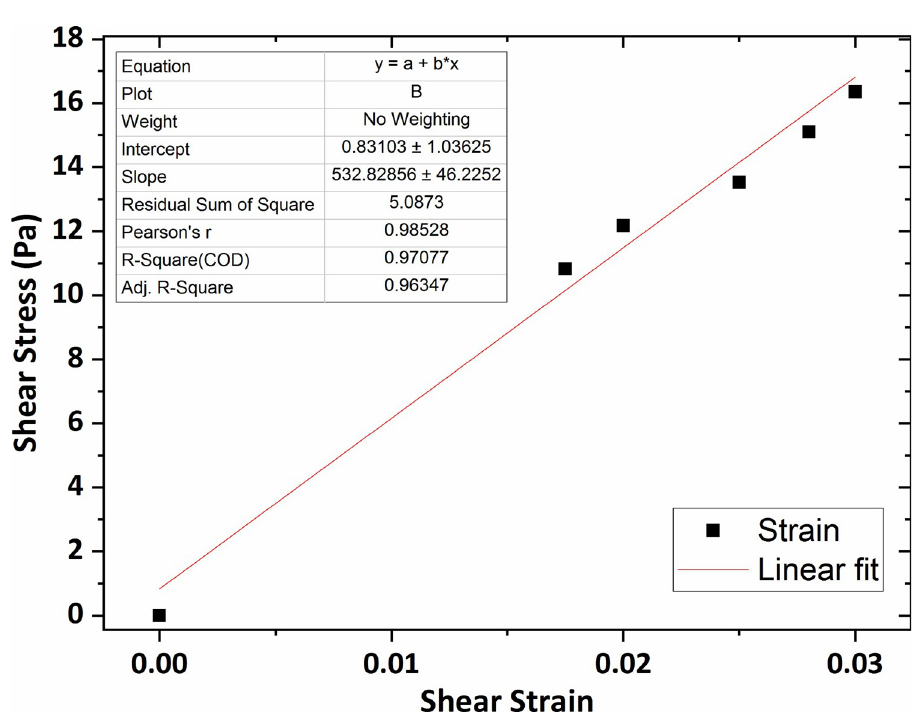
Fig 10. The graph of shear stress versus shear strain for the agarose gel of 0.5 wt % percent concentration.